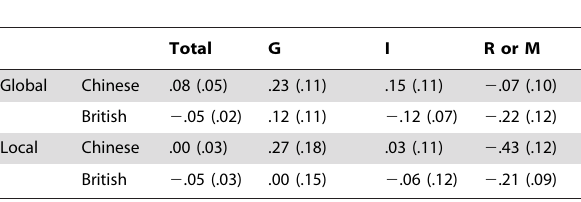
Table 6. Mean Values of B 0 for Each Attribution of Each Group in the Classification Test for Target